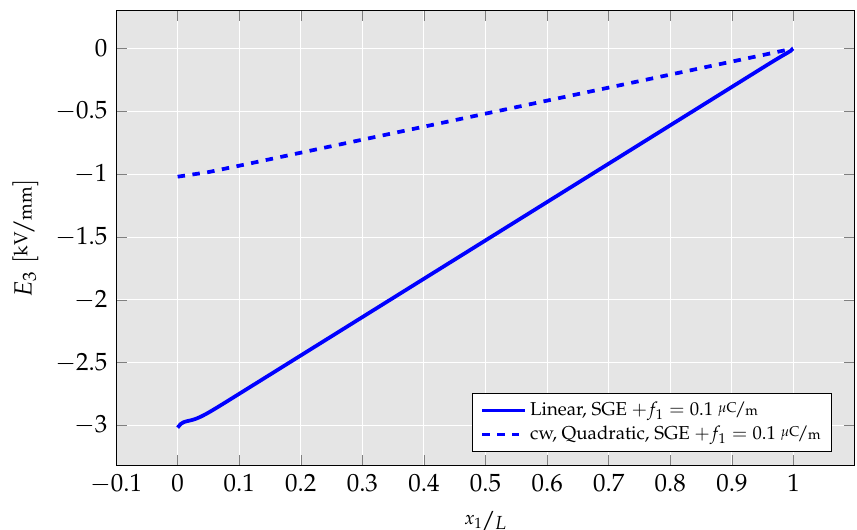
Figure 14. Comparison of electric field calculated by using linear and quadratic element along the length of the beam.